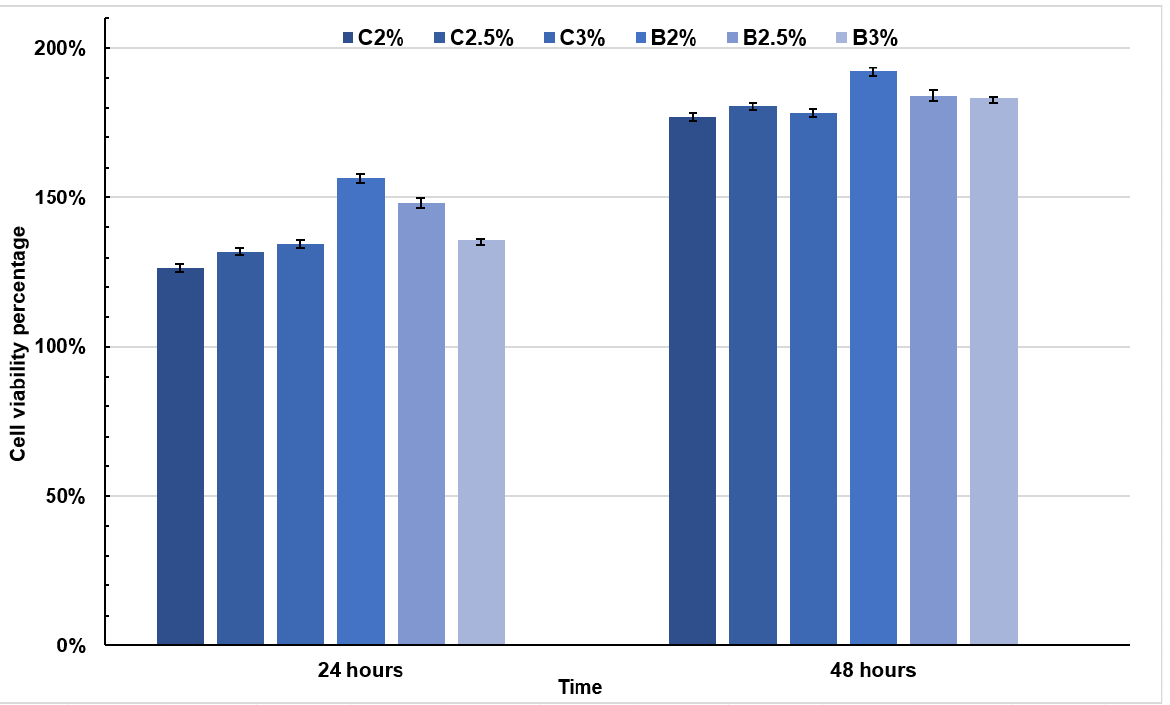
Figure 7. HDFn proliferation at 24 and 48 h grown on composite and bi-layer films, as assessed by MTT test.